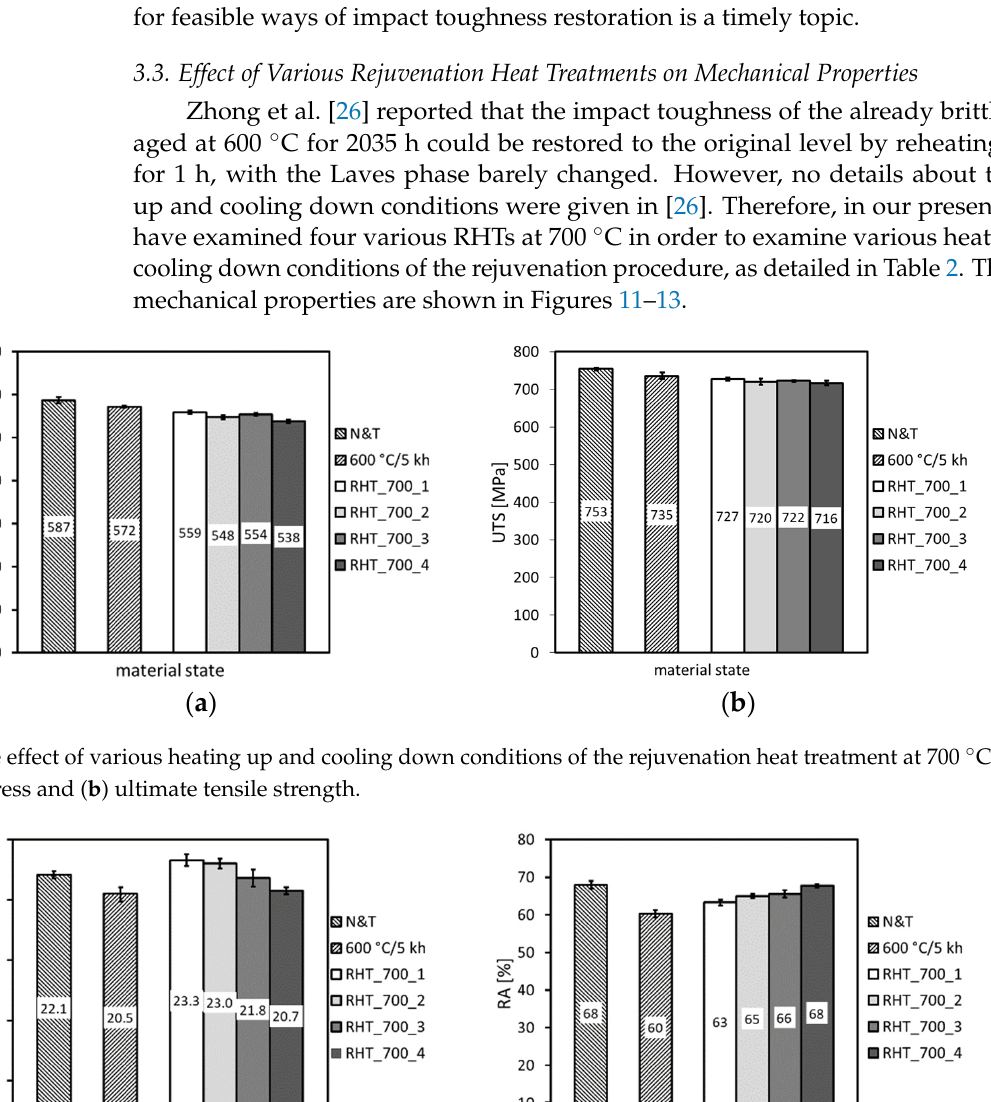
Figure 13. The effect of various heating up and cooling down conditions of the rejuvenation heat treatment at 700 °C for 1 h on ( a ) hardness and ( b ) impact toughness.